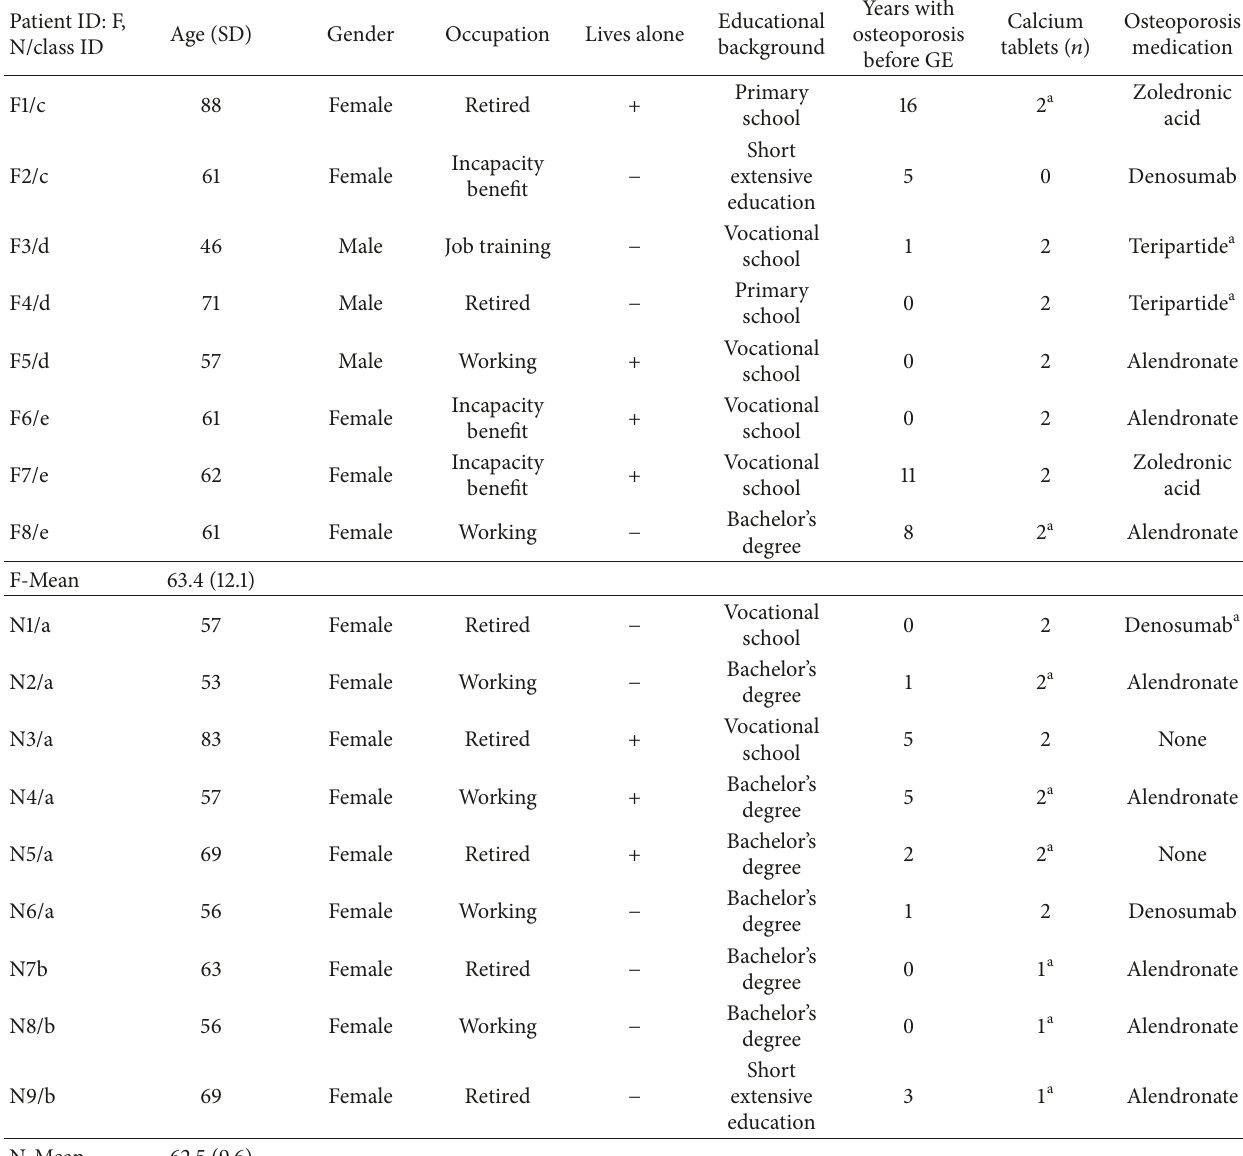
Table 1: Patients’ demographic and osteoporosis related characteristics at the end of study period. Patient ID: